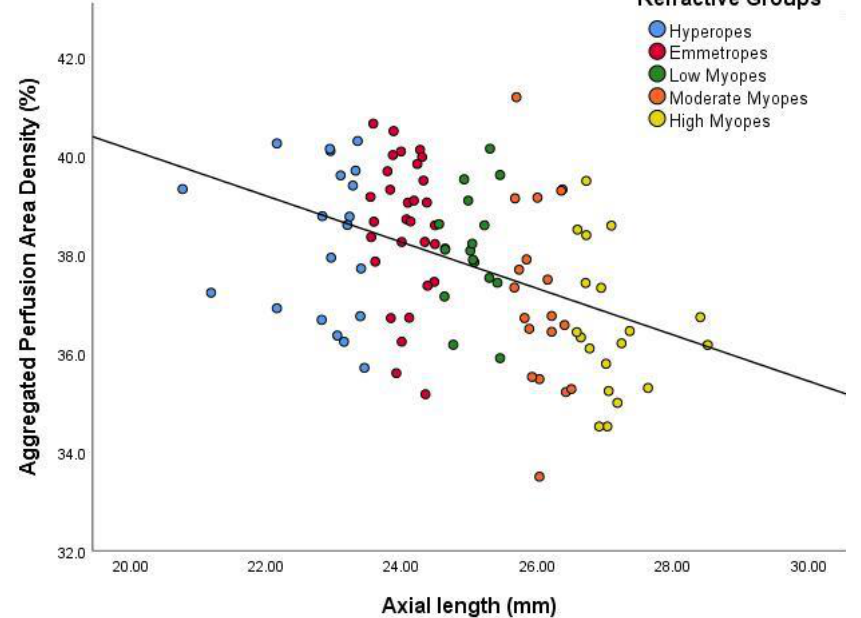
Figure 2. Scatter plot demonstrating the relationship between aggregated perfusion area density and axial length. The colours distinguish the subjects for their particular eye size bin. The regression line indicates a significant inverse relationship (r 2 = 0.186, p < 0.001).